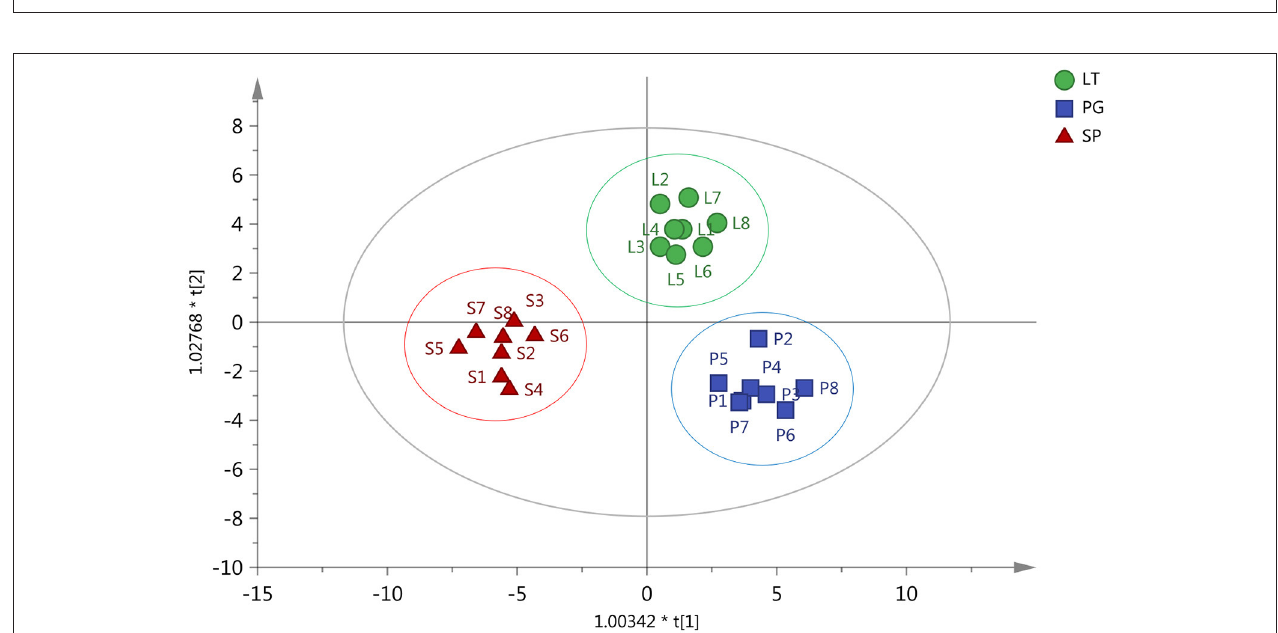
FIGURE 2 | PCA score plot of test samples and quality control (QC) samples ( , QC sample; test sample).